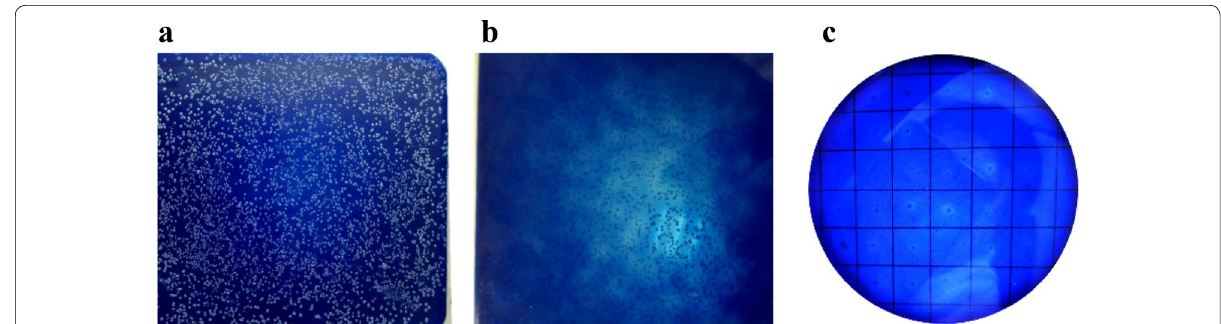
Fig. 1 The RBB-xylan substrate plate to screening the mutant library. The mutants in the library were spread on the RBB-xylan substrate plate method with IPTG induction for preliminary functional screening ( a , b ). The mutants with obvious bigger hydrolysis circle compared with the wide type were rescreened on the RBB-xylan substrate plate ( c